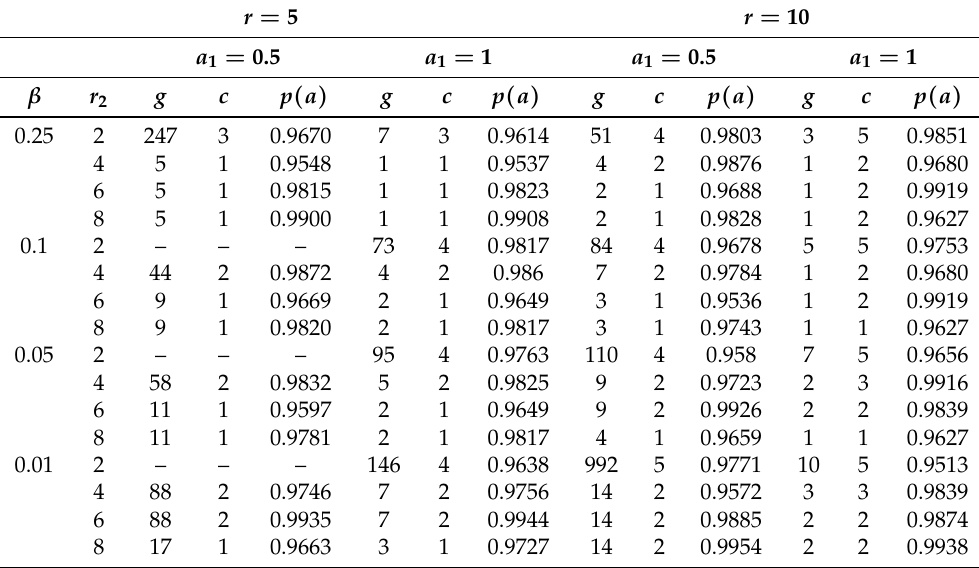
Table 1. GASP under CBellW model, β = 1 and λ =